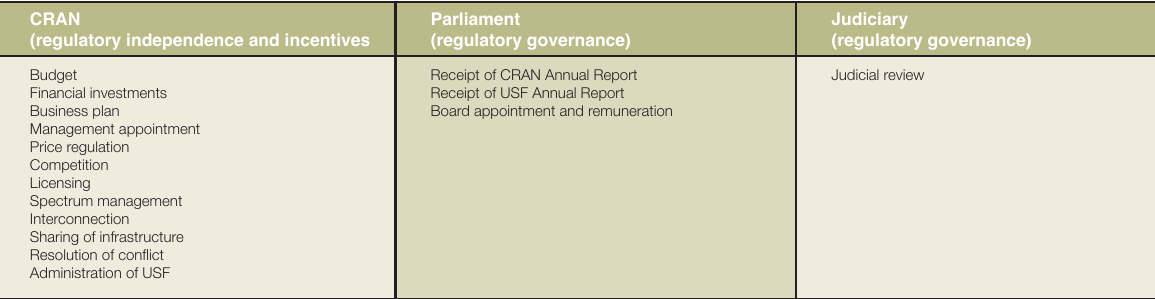
TABLE 1: PROPOSED ROLE SEPARATION CRAN (regulatory independence and incentives